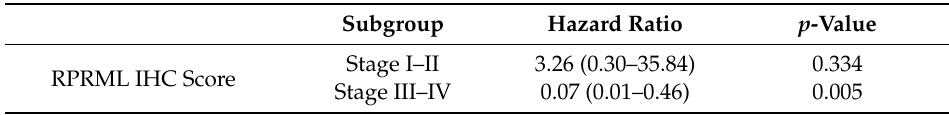
Table 1. Association analysis of RPRML IHC score and overall survival by tumor–node–metastasis (TNM) stage